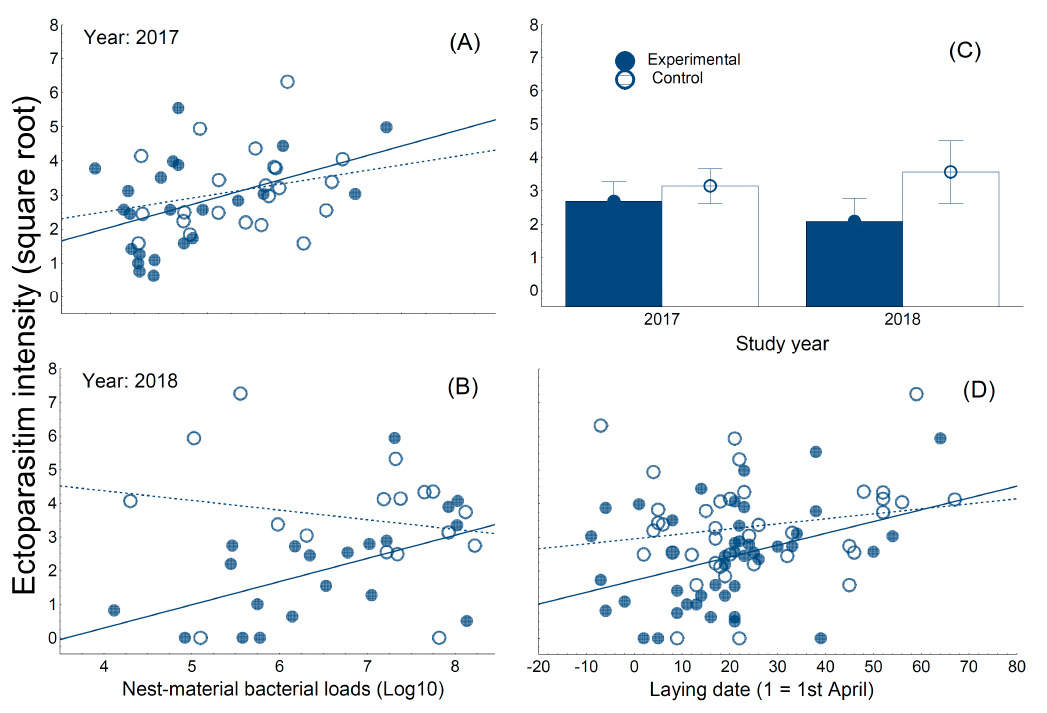
Figure 1. Associations between the ectoparasitism intensity of hoopoe nestlings and bacterial loads of nest-materials that were (filled dots) or were not (open dots) autoclaved before reproduction started in the 2017 ( A ) and 2018 ( B ) study years. We also show weighted means ( ± 95% CI) of ectoparasitism intensity su ff ered by hoopoe nestlings developing in nest-boxes with nest-material that were or were not autoclaved in the 2017 and 2018 breeding seasons ( C ). Finally, ( D ) we also show the association between ectoparasitism intensity and laying date of hoopoe nests with autoclaved or not autoclaved nest-material. Solid and dashed lines are regression lines for experimental and control nest-boxes.